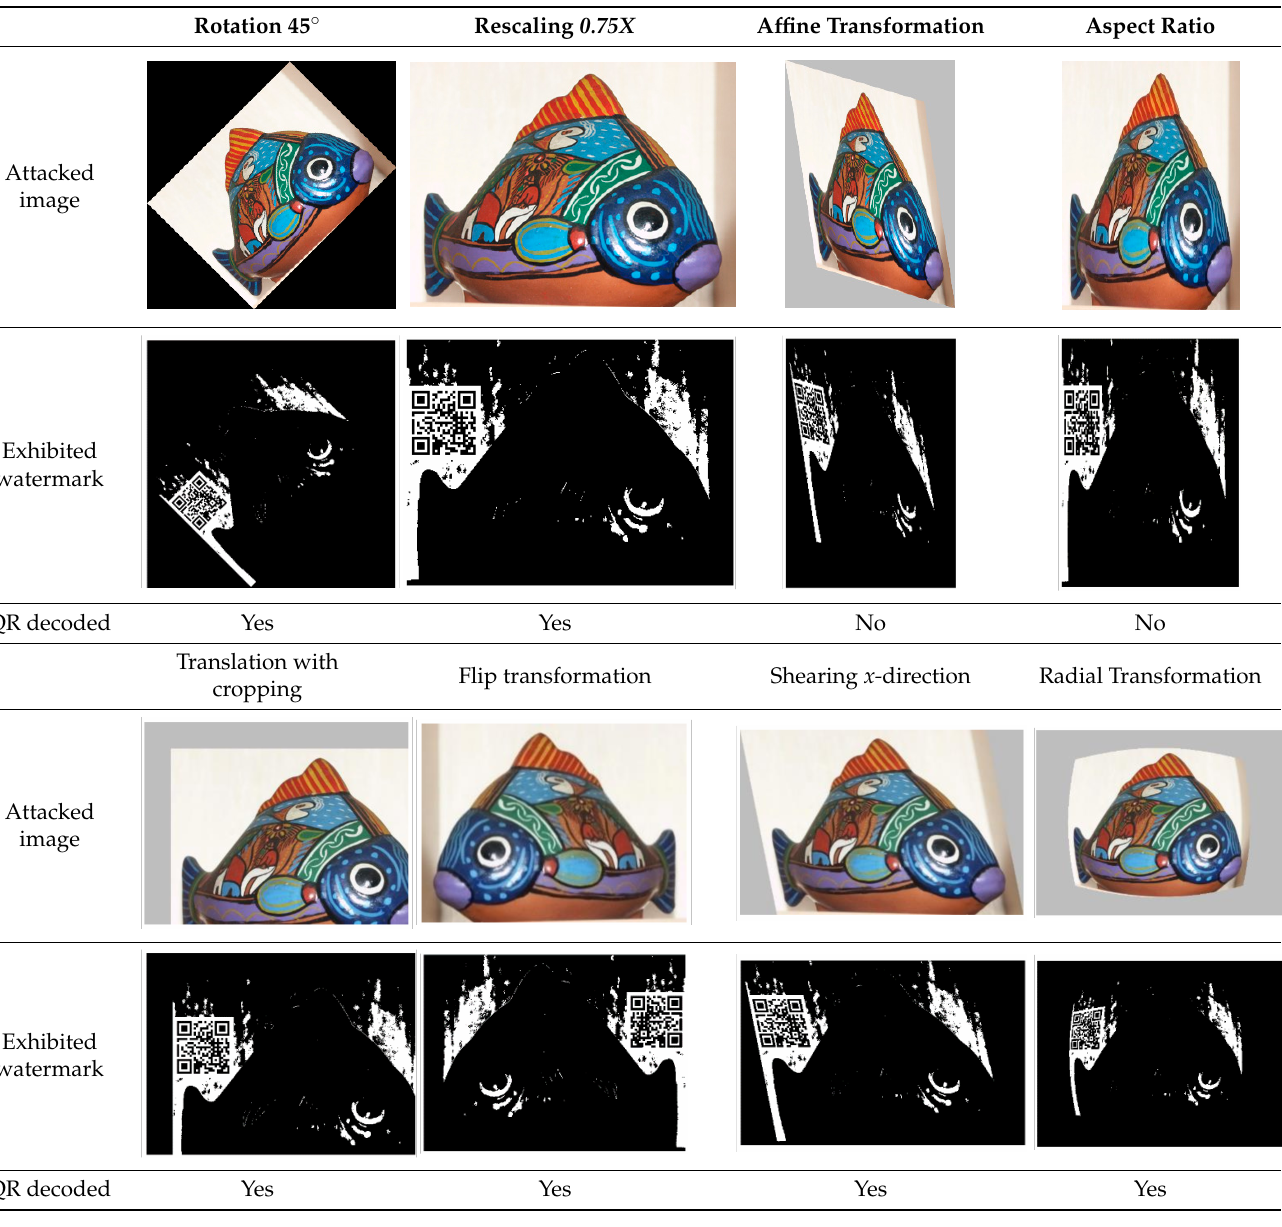
Table 6. Robustness against geometric attacks.